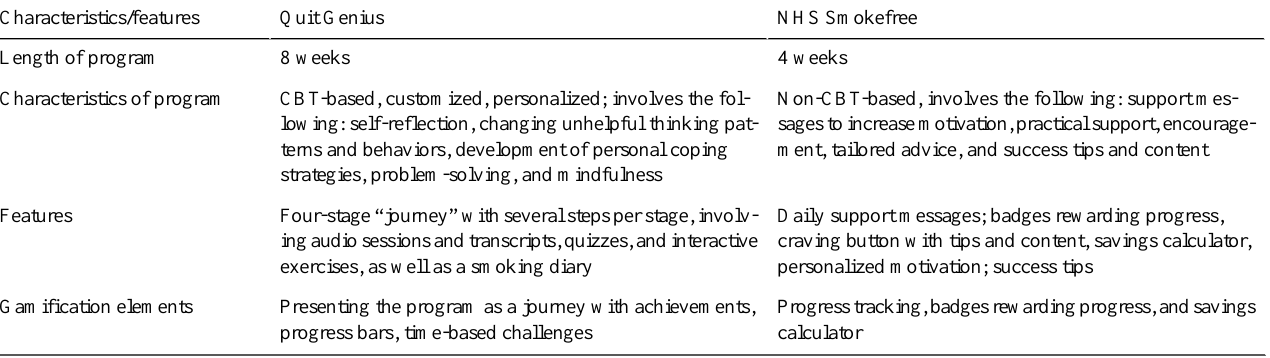
Table 2. Characteristics and features offered by the Quit Genius and Smokefree apps. CBT: cognitive behavioral therapy; NHS: National Health